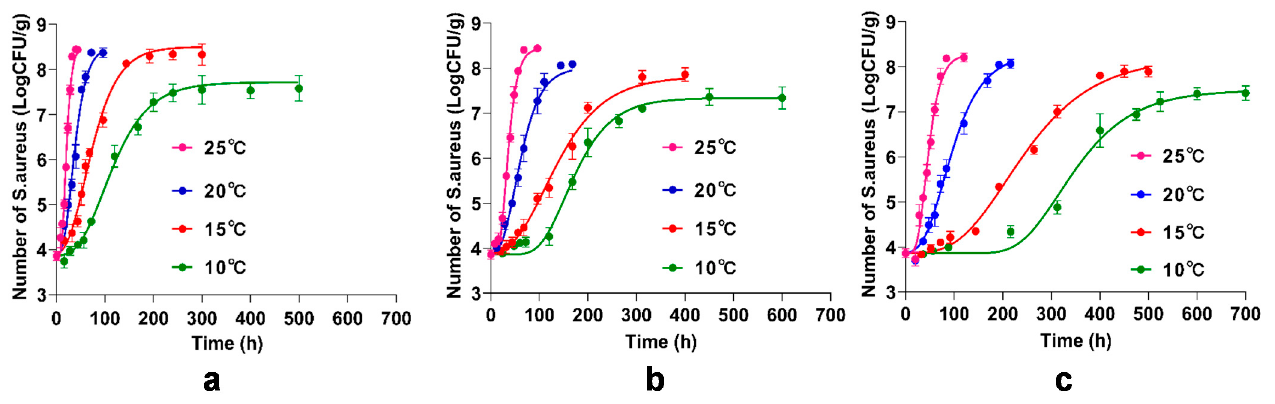
Figure 6. The Primary model for the inhibitory of BITC and γ -CD-BITC on S. aureus growth in cooked chicken breast stored at 10, 15, 20, and 25 °C. ( a ) Control, ( b ) BITC, and ( c ) γ -CD-BITC.